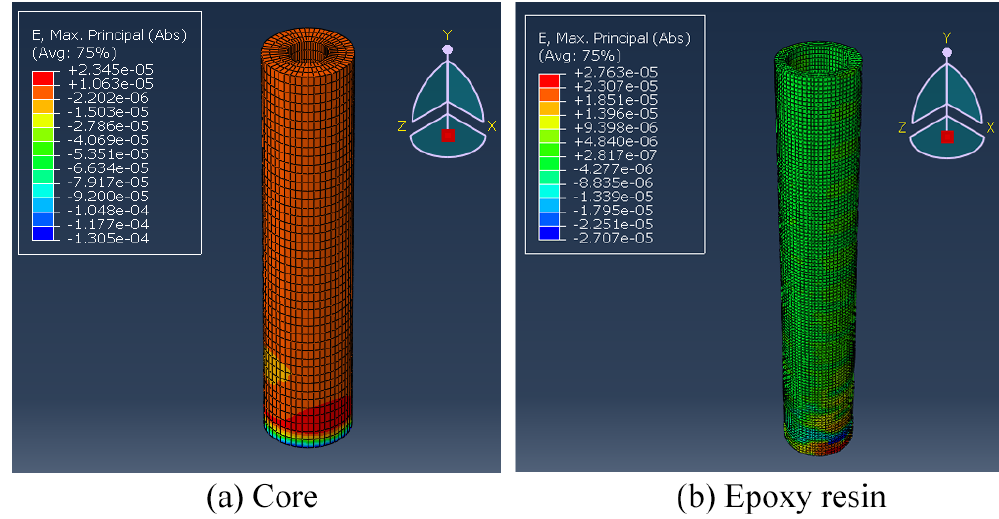
Figure 19. The absolute maximum principal-strain nephogram of the core and epoxy resin after overcoring.